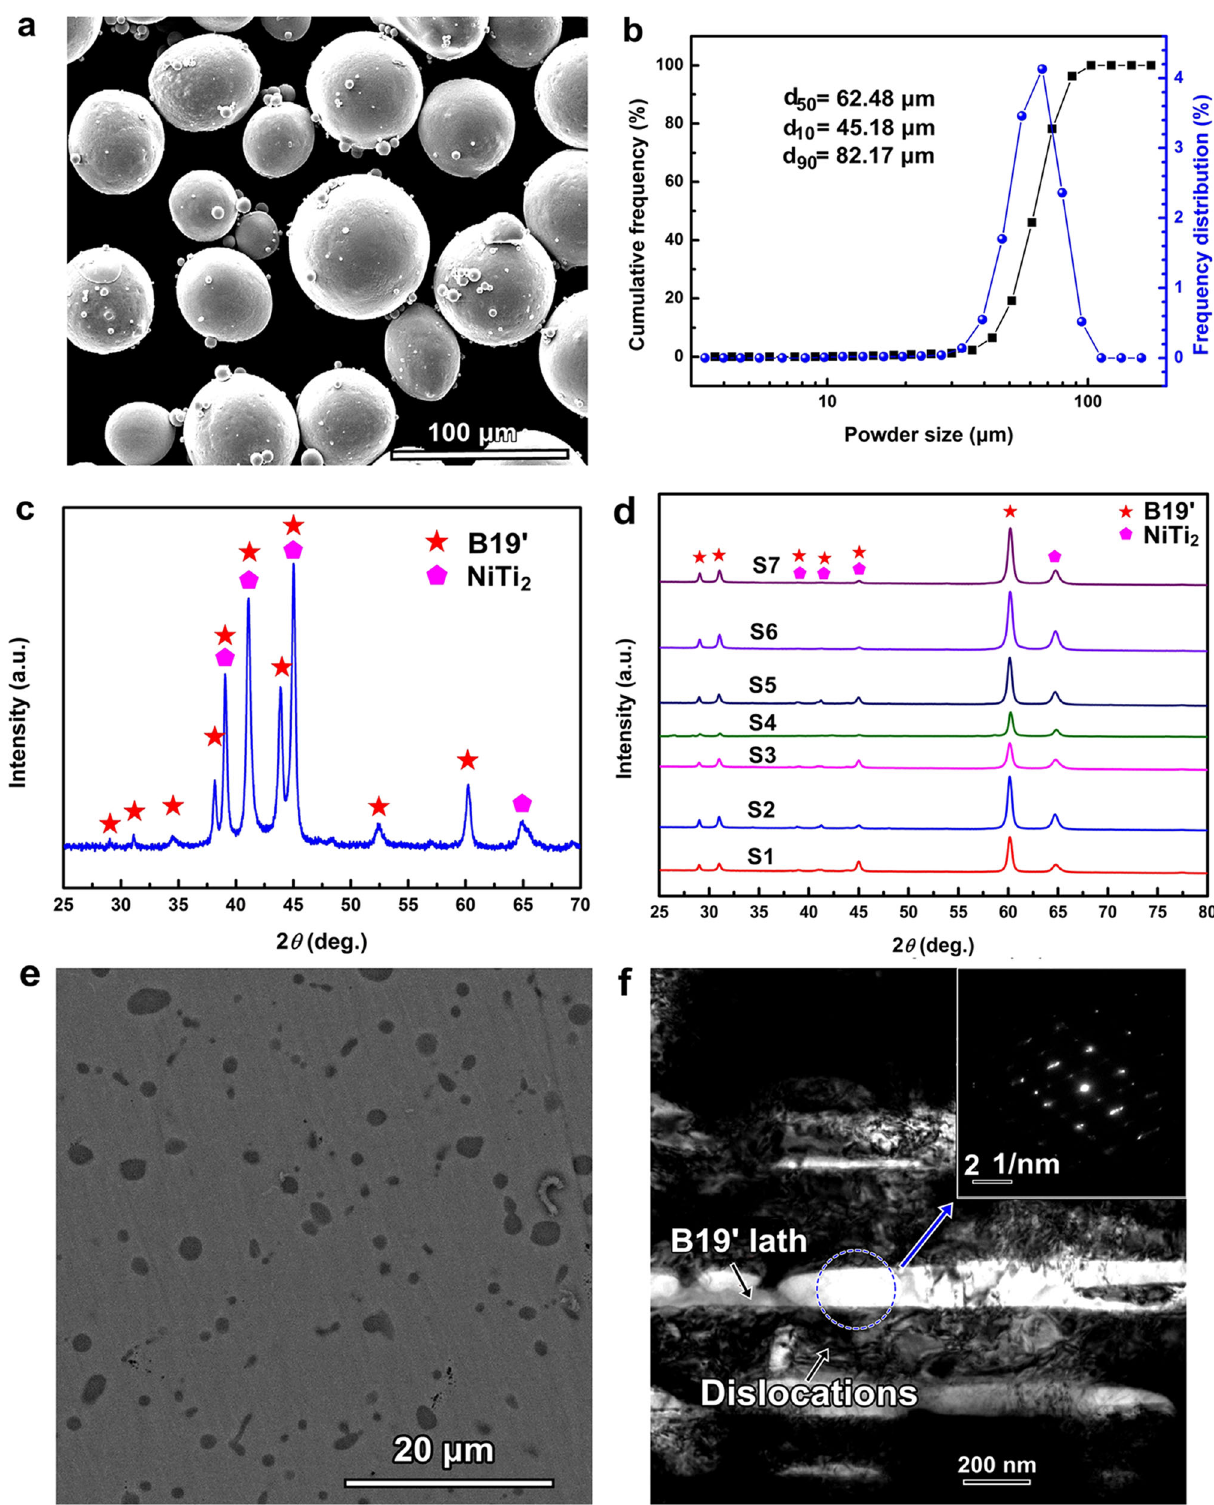
Fig. 1 Microstructure and phase composition of NiTi powders and EBM NiTi alloys. a SEM morphology, b size distribution, and c XRD phase composition of NiTi alloy powder; d XRD phase composition of different EBM NiTi alloys, e backscattered electron image of S5, f TEM bright fi eld image of S5 (the inset is